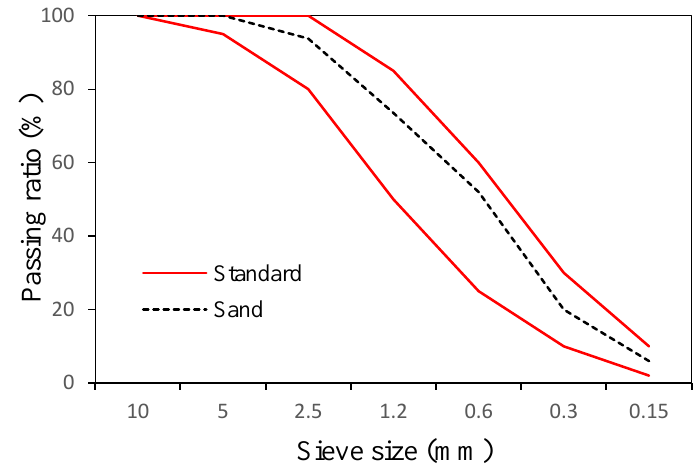
Figure 1. Particle size distribution of fine aggregates used in this study.